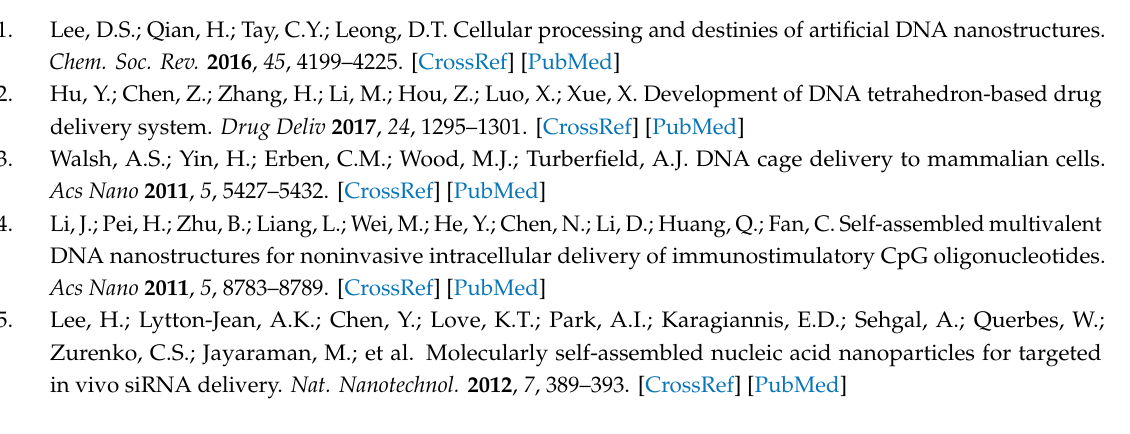
Supplementary Materials: Table S1. The sequences of DNA tetrahedrons; Table S2. The polydispersity index (PDI) of DNA particles prepared in di ff erent conditions determined by DLS (Data were meanSD, n = 3); Table S3. Yields of DNA tetrahedrons under di ff erent conditions (%). (Data were meanSD, n =